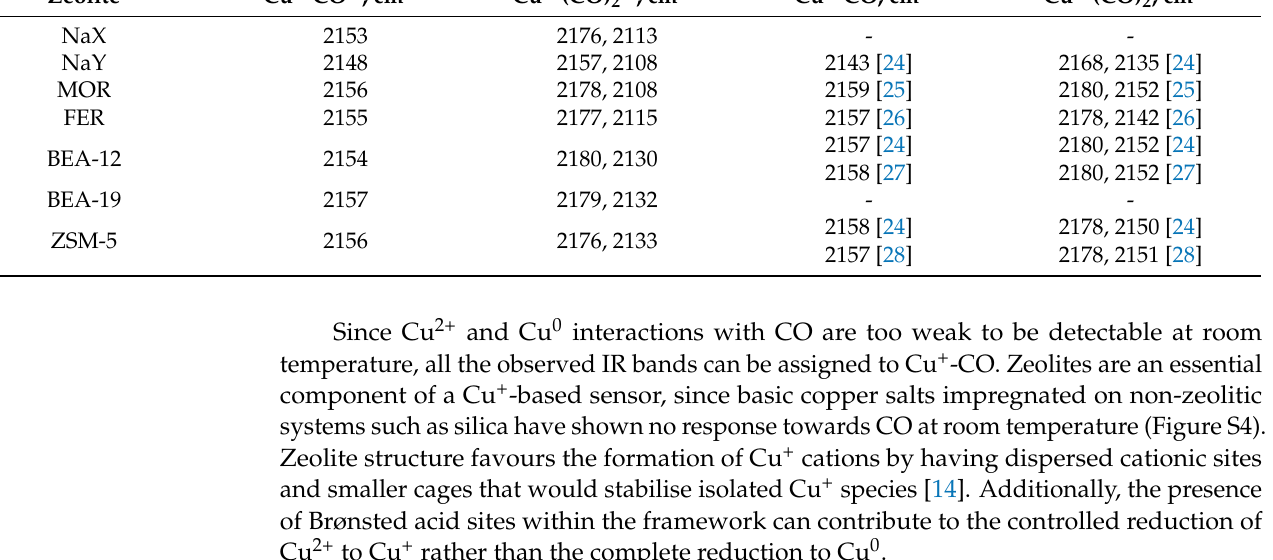
Table 2. FTIR bands of CO adsorbed on Cu ‐ impregnated zeolites (* data obtained in this work).